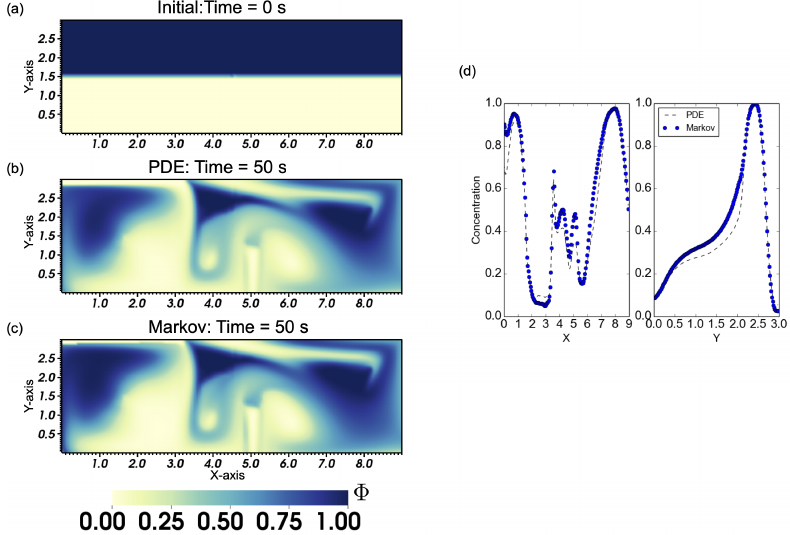
Figure 4. ( a ) Initial condition for the concentration. ( b ) Numerically solved PDE transport for contaminant evolution at time 50 s. ( c ) Contaminant evolution using the transfer operator at time 50 s. ( d ) Contaminant concentration comparison between PDE and Markov model along center X and Y axis of the computational